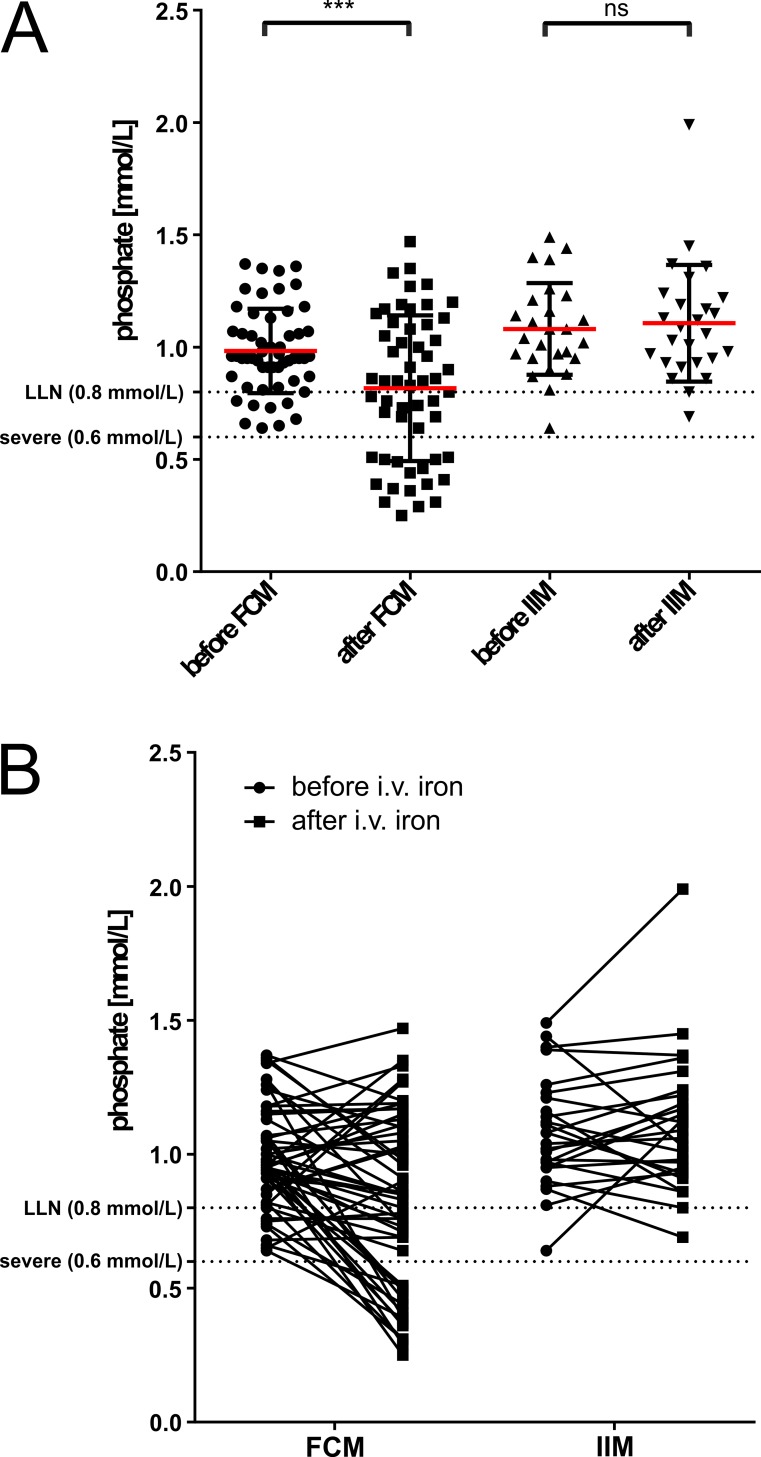
(A) Plasma phosphate concentration before and after FCM or IIM. Mean plasma phosphate decreased significantly in the FCM group. Severe hypophosphatemia (< 0.6 mmol/L) was exclusively found after FCM. (B) Paired analysis shows a decline in plasma phosphate concentration from before to after the infusion of FCM in the majority of patients. Only one patient developed moderate hypophosphatemia after the infusion of IIM.